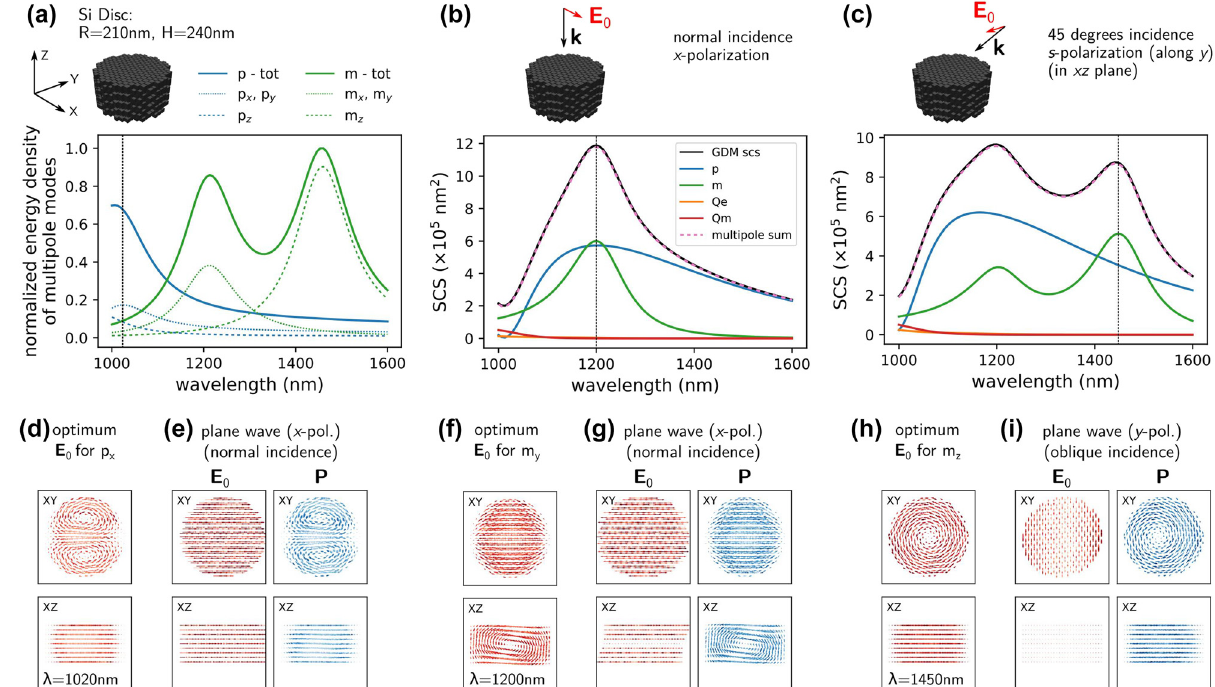
Figure 6: Generalized polarizability tensors as visualization tool for the local coupling strength of the illumination to different multipole = 1). (a) Sum of the tensor norms of the generalized polarizabilities of moments of a silicon disc ( R = 210 nm, H = 240 nm) in air ( n env electric (blue) and magnetic (green) dipole moments. The integrated norm of the column vectors corresponding to the Cartesian components of the dipole moments are shown as thin dotted ( x and y components) and dashed ( z component) lines. (b) Scattering spectra and according multipole decomposition for normal illumination with a linearly x -polarized plane wave. (c) Same as in (b) but with oblique incidence (45 ◦ , s -polarized) (d) Red: Optimum illumination field distributions at the wavelength 1020 nm, with maximum possible x and y electric dipole moment. (e) Plane wave illumination (red) and according internal field distribution (blue). (f, g) like (d, e) but showing the optimum = 1200 nm (f) and the internal field induced by a normal incidence plane dipole moment at 𝜆 illumination field to induce a magnetic m 0 y moment (h) compared to the internal field induced by an oblique s -polarized plane wave wave (g). (h, i) Ideal field to excite a magnetic m z